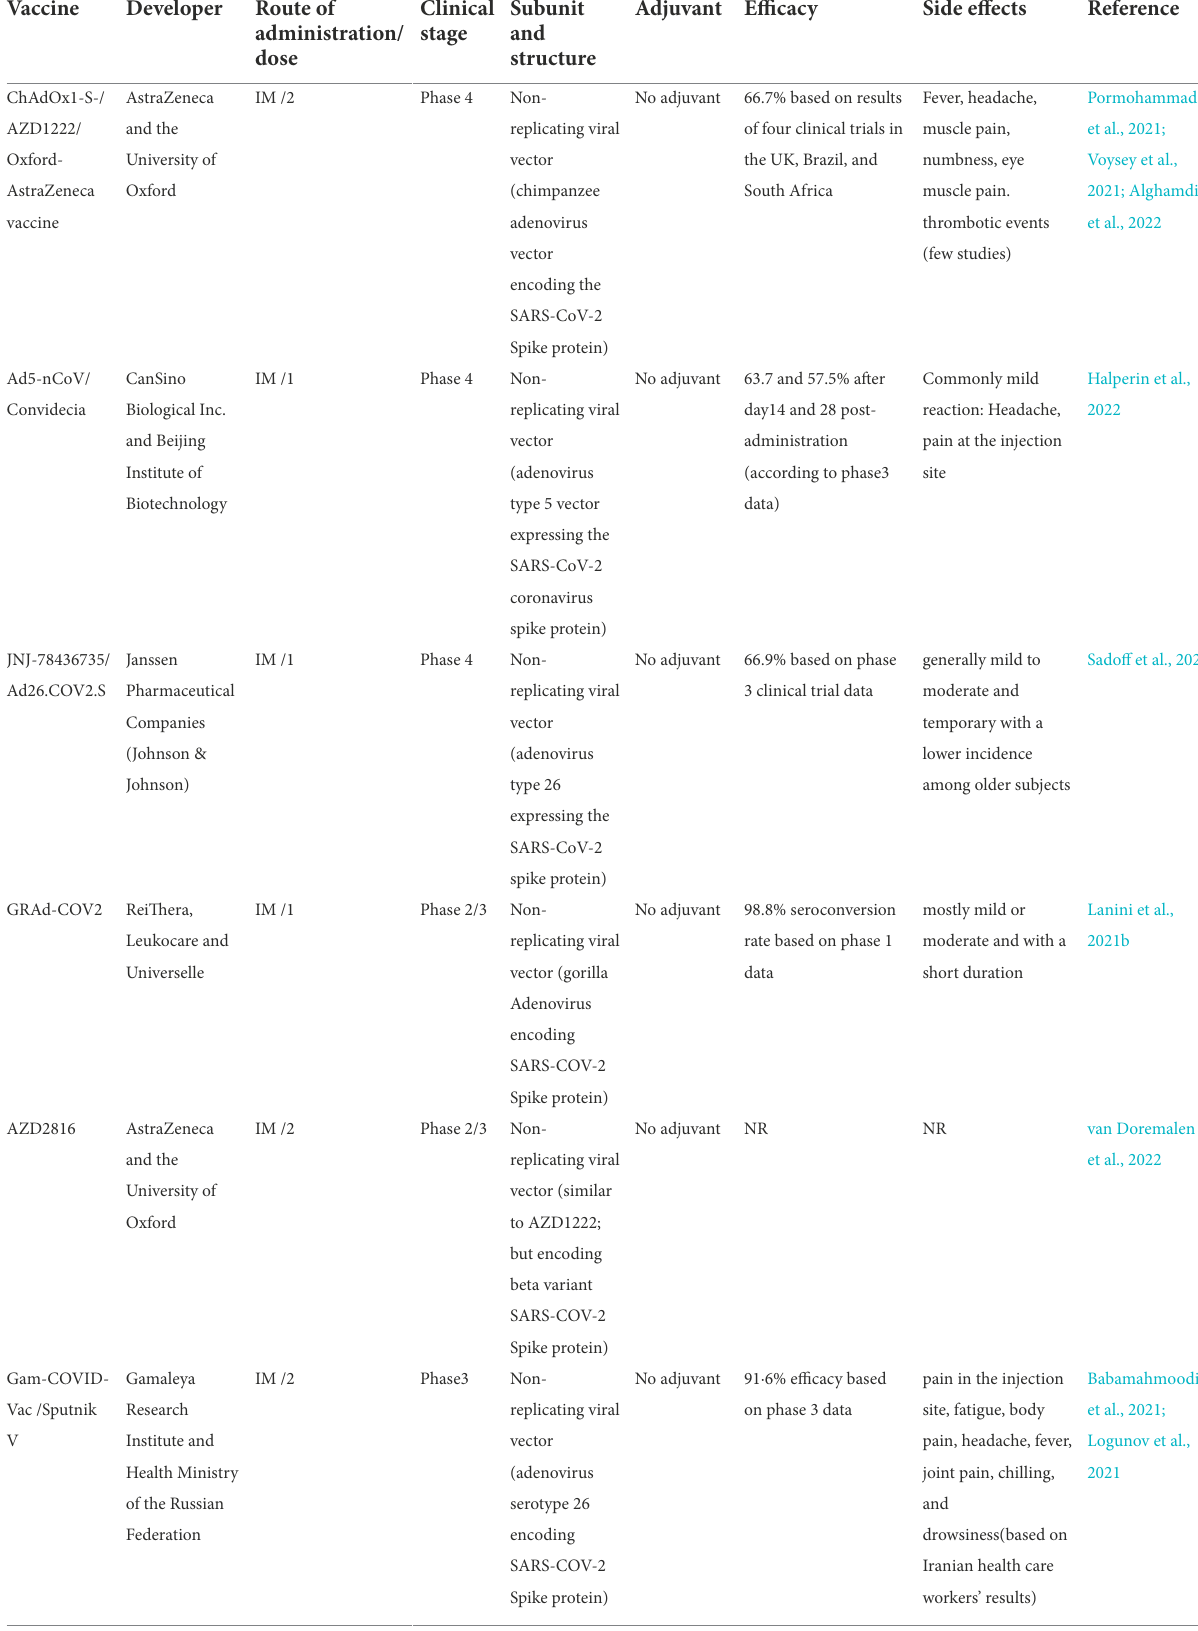
TABLE 3 Characteristics of COVID-19 non-replicating viral vectors vaccines. Vaccine